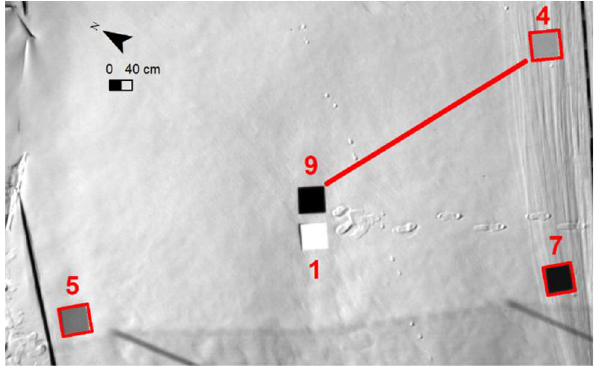
Figure 2. The design of the field experiment. Figure shows the distribution of calibrating (1, 9) and validation (4, 5, 7) targets. Red squares mark the validation targets.